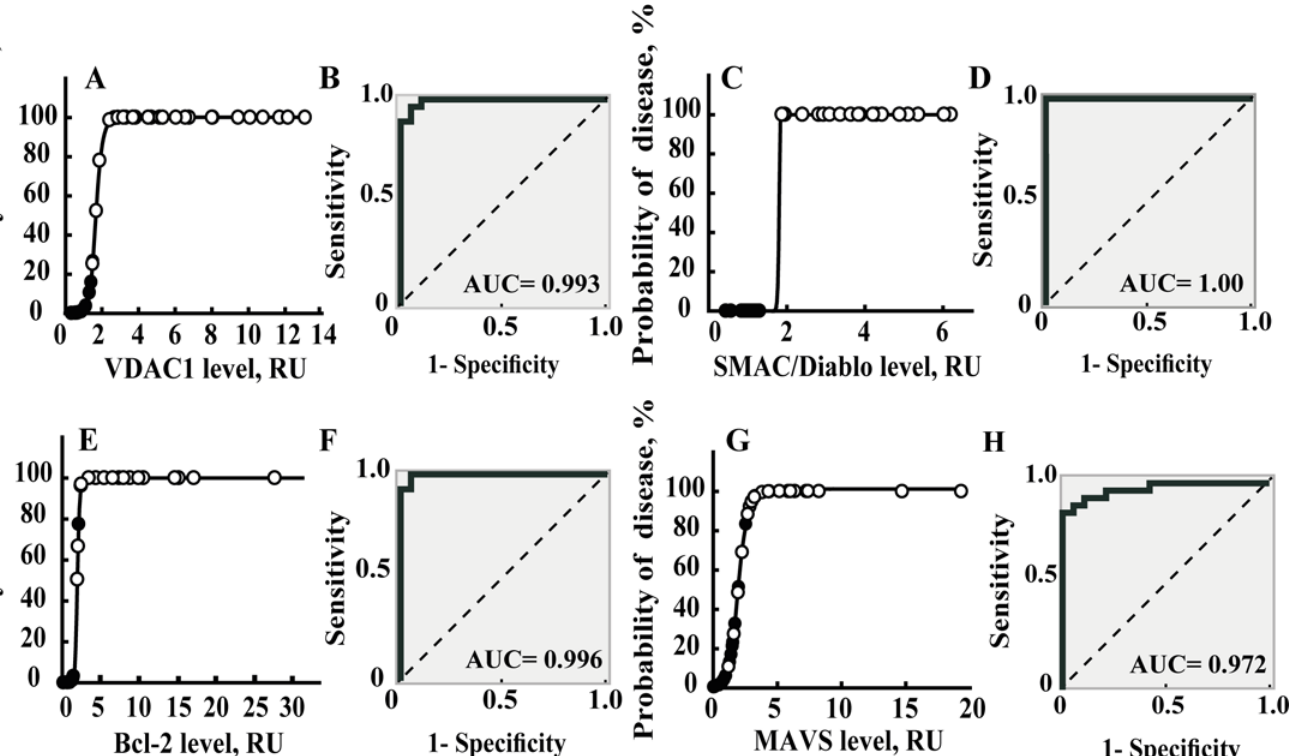
Fig 6. Binary logistic regression testing for specificity, sensitivity and overall CLL predication based on the relative expression of apoptosis- related proteins. Bivariance analysis was performed based on the relative expression of apoptosis-related proteins from Fig 3, considered as independent variables. Data was analyzed in terms of the sensitivity and specificity by assessing levels of apoptotic-regulating proteins based on a cut-off value of 0.5, using binary logistic regression analysis. Probability of disease is presented for healthy donor ( ● ) and CLL patient (O) for VDAC1 (A), SMAC/Diablo (C), Bcl-2 (E) and MAVS (G). The dependents were determined as zero for healthy donors and 100 for CLL patients. The binary logistic regression model was carried out with a 95% confidence interval. Data was also analyzed using ROC curves of VDAC1 (B), SMAC/Diablo (D), Bcl-2 (F) and MAVS (H) expression levels in PBMCs samples from CLL patients and healthy donors. The AUC of the ROC curves for classifying CLL are presented in each curve.